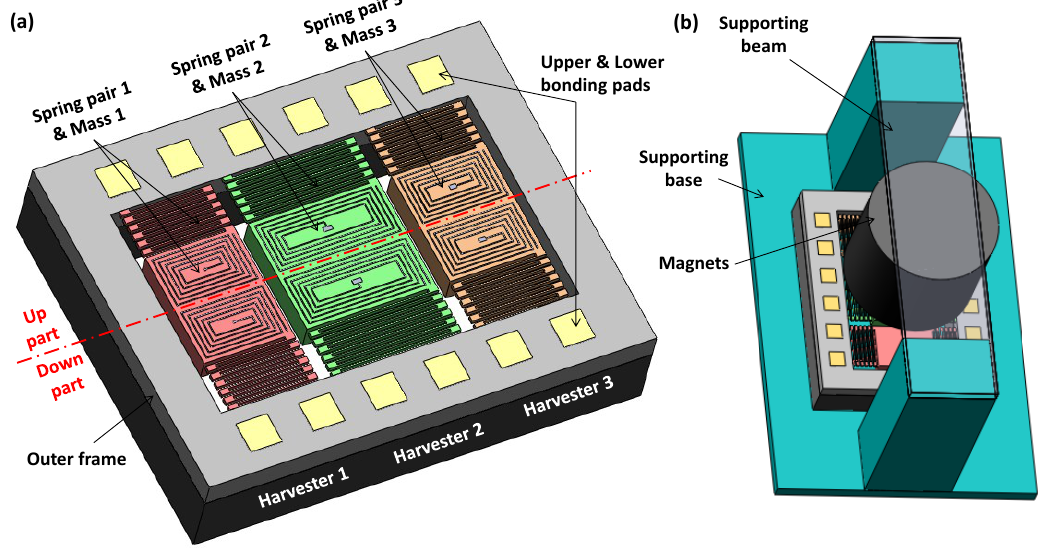
Figure 1. 3D drawing of ( a ) the proposed multi-frequency microelectromechanical systems (MEMS) energy harvester (EH) chip and ( b ) the assembled electromagnetic EH